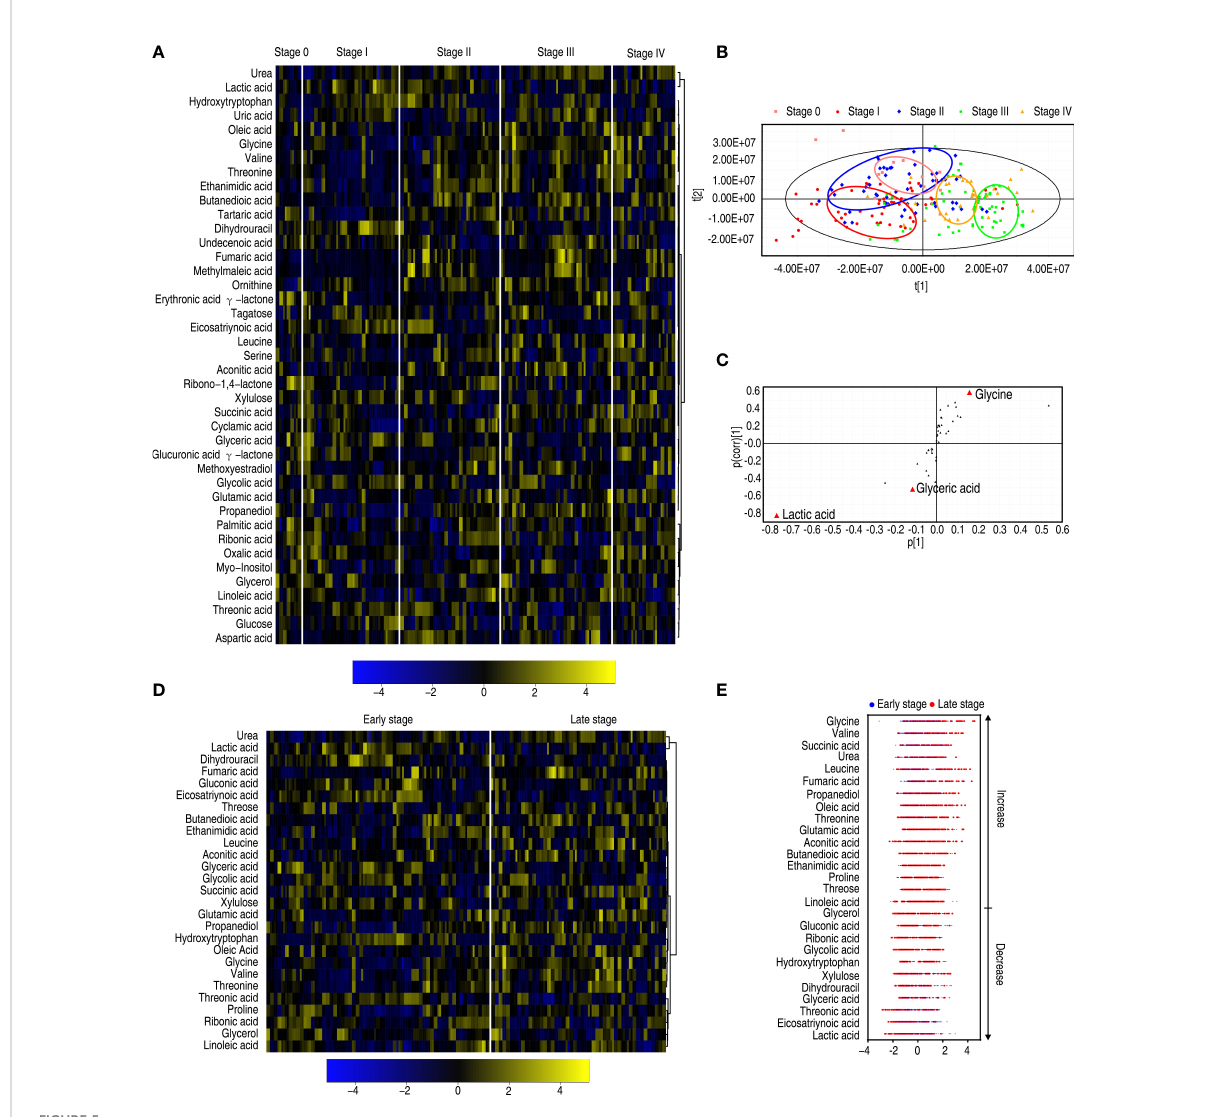
FIGURE 5 Differential metabolomes among stages 0, I, II, III, and IV of patients with esophageal cancer. (A) Heatmap showing fi ve stages of esophageal cancer. (B) OPLS-DA of fi ve stages of esophageal cancer. (C) S-plot is generated from OPLS-DA. The triangle represents metabolites and candidate biomarkers are highlighted in red. (D) Heatmap showing stage 0 – II and stage III – IV esophageal cancer. (E) Z -score plot of differential metabolites based on control (stage 0 – II esophageal cancer). The data of the stage III – IV esophageal cancer group were scaled to the mean and standard deviation of control. Each point represents one metabolite in one technical repeat and colored by sample